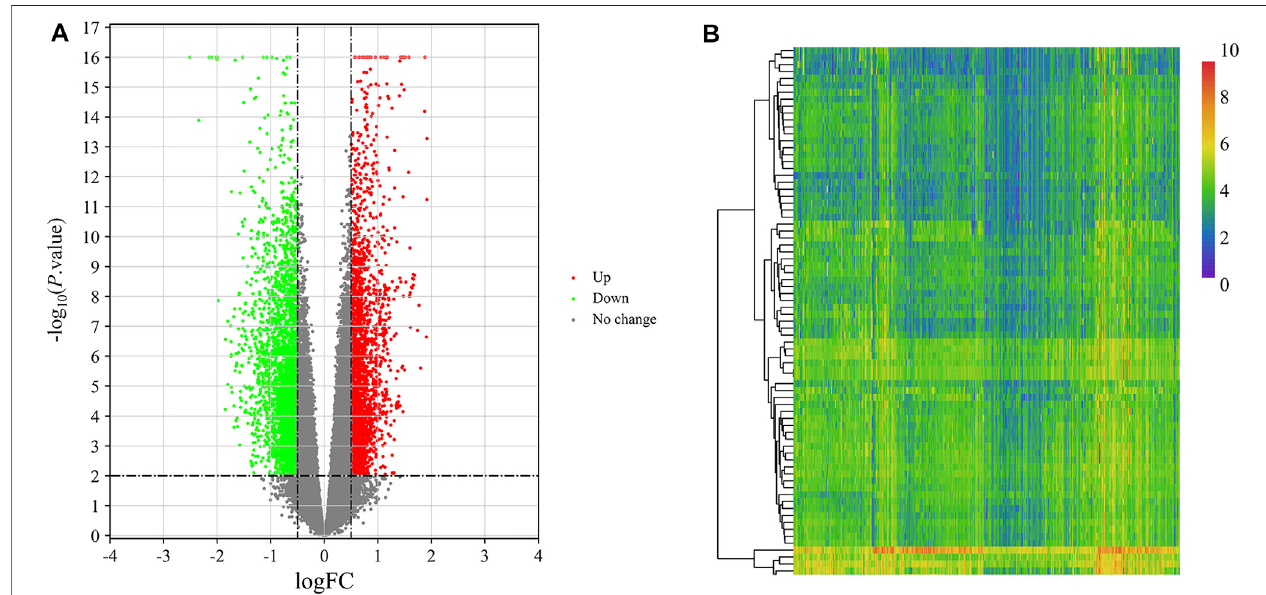
FIGURE 2 | Identi fi cation of DEGs and DEMs in VaD. (A) Volcano plot of GSE122063 for the analysis of DEGs. (B) Heat map of the identi fi ed DEMs from the GSE120584 dataset.